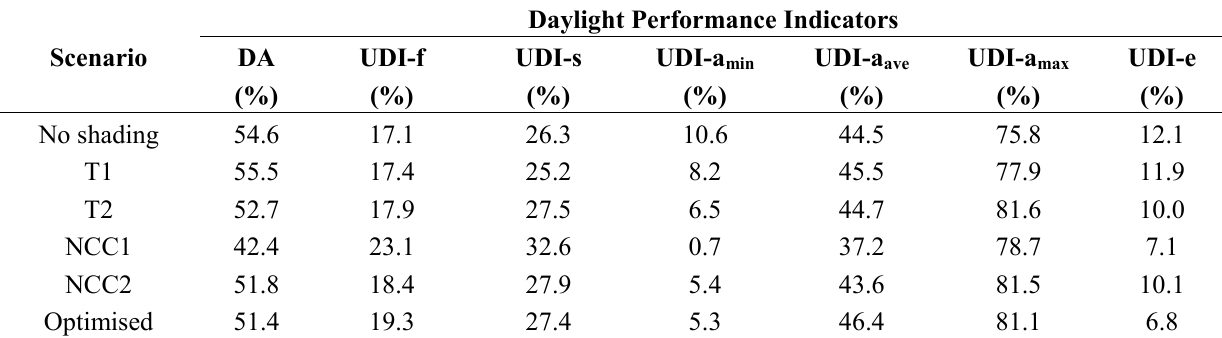
Table 5. Daylight performance indicators for each tested scenario.